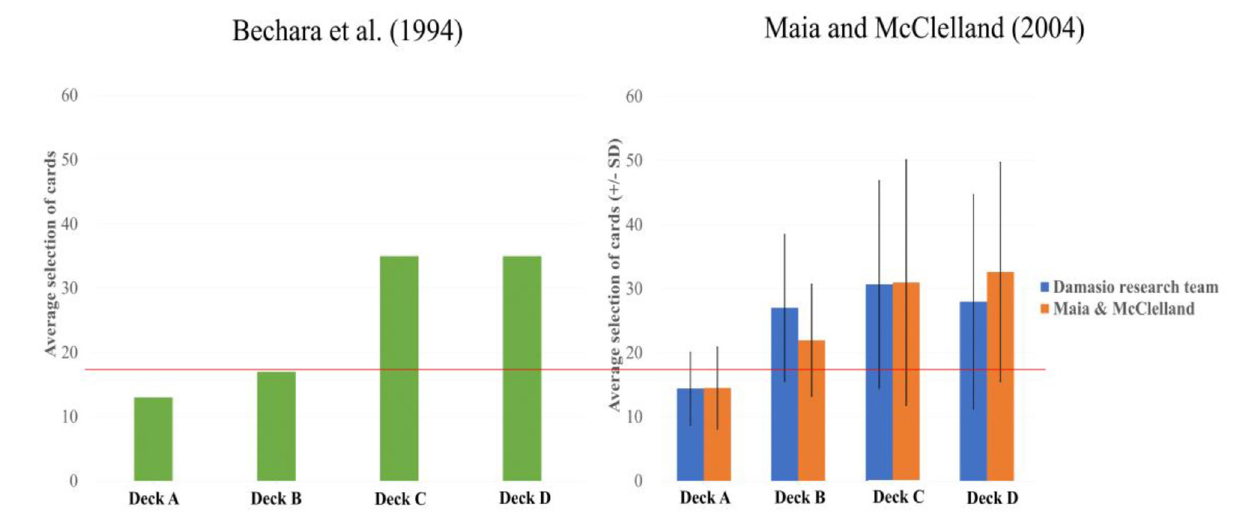
FIGURE 1 | The average deck selection frequency for the four IGT decks. Left-hand chart: data from the original experiment, as generated from Bechara et al. (10). Right-hand chart: the orange bars represent the data from Maia and McClelland ( 1), while the blue bars represent the results obtained by Maia and McClelland when they replicated the Bechara et al. (11) approach. This chart was generated from Maia and McClelland’s (1) original data. The right-hand chart presents the average deck selection frequency in Bechara et al. ( 11) and the study of Maia and McClelland (1), taking their different methodologies (see also Supplementary Figures 1, 2 ) into account. The analysis shows that, following Bechara et al.’s ( 11) procedures, there was no difference in terms of participants’ preferences for Decks B, C, and D. However, participants showed a lower preference for Deck B than for Deck D, indicating that Maia and McClelland’s questionnaire had influenced participants by alerting them to the negative properties of Deck B, thereby reducing the frequency with which Deck B was selected. It should be noted that participants in both studies selected Deck B more often than Deck A, a result that counters the original hypothesis proposed by Damasio and by Bechara et al. ( 9–11), as well as the view held by Maia and McClelland that participants possessed explicit knowledge relating to gains. The color bars represent the mean number of card selections in each deck, and the error bars mark the 1 positive/negative standard deviation from the mean selection number of each deck. Due to the limited number of participants in Maia and McClelland’s study, the error bars are only for presentation purposes and not for data